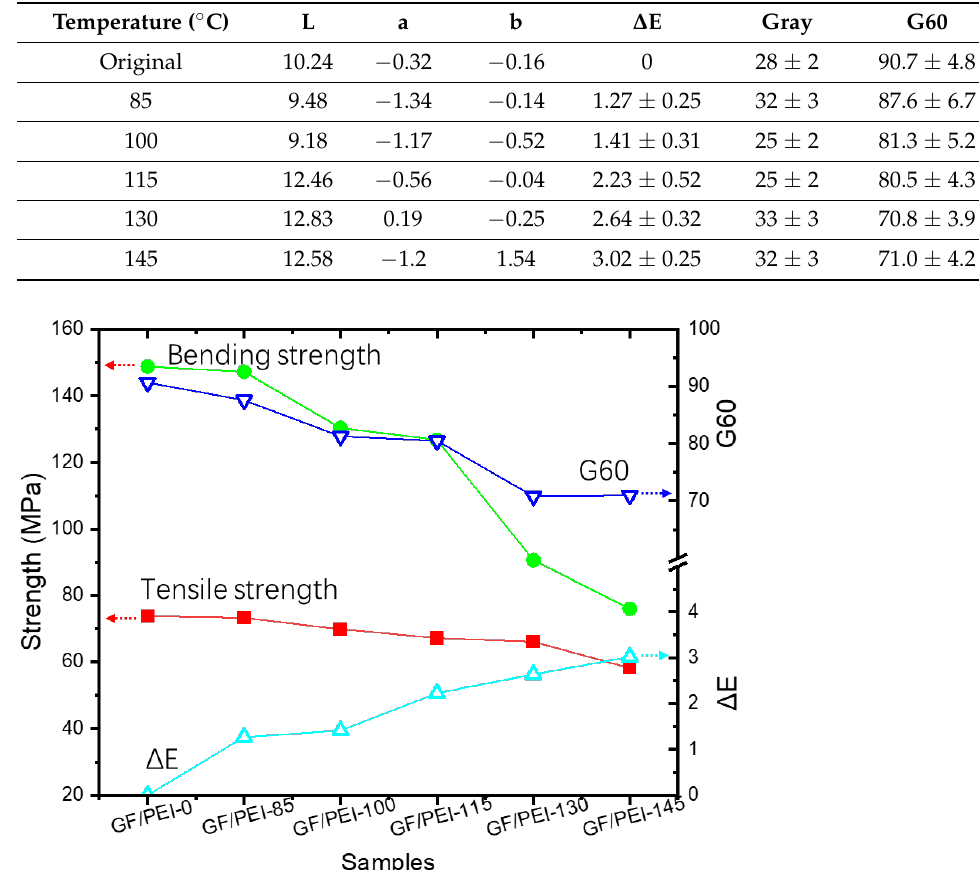
Figure 5. Correlation between mechanical strength and color difference of the GF/PEI samples